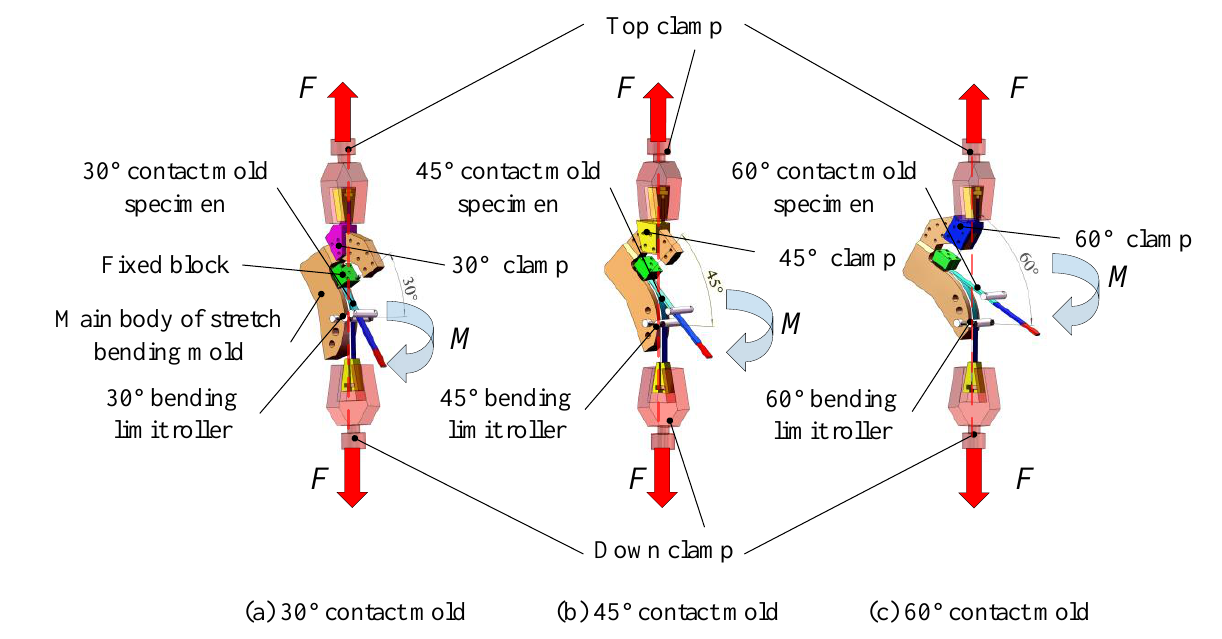
Figure 8. Equipment and methods of the equivalent stretch-bend experiment.